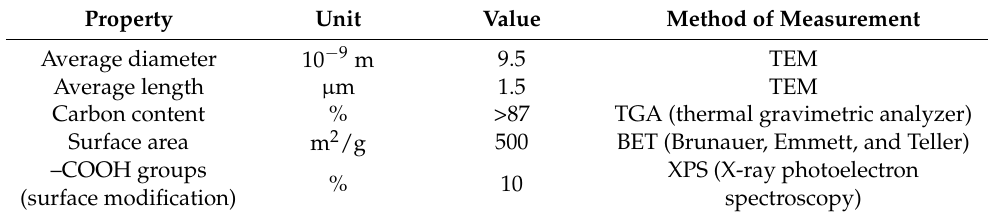
Table 1. Specific characterization of CNTs (Sigma-Aldrich code: 755125, Nanocyl Inc., Belgium) and methods of measurements.